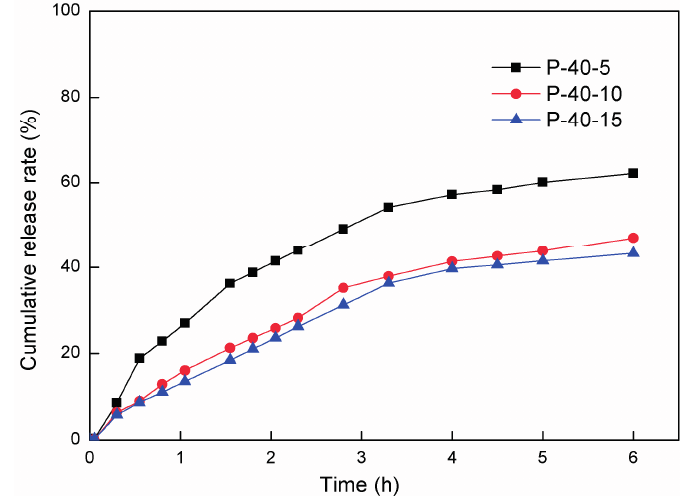
Figure 5. Comparison of the RB release rate time curves measured for the release of RB from P-40 series films with different DAS content at 37 °C with